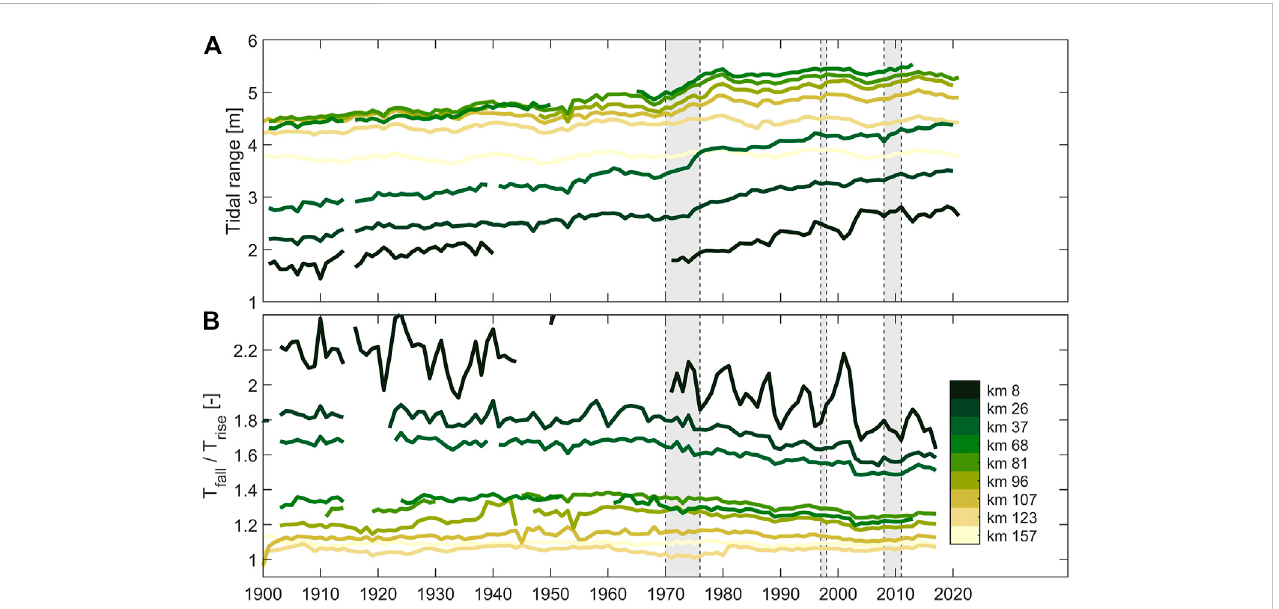
FIGURE 5 Annualtidalrange (A) andratioofthedurationfallingtidetorisingtide (B) intheScheldtestuary.Thetidalrangeupto2011isfromWinterwerpetal.(2013) andafter2011fromhttps://www.scheldemonitor.be/;ebbto fl oodratiosarefromVandenbruwaeneetal.(2019a).ThedataisoriginallycollectedbytheDutch Ministry of Public Works and the Hydrological Information Centre (HIC) of Flanders Hydraulics Research. Periods of major deepening are indicated with grey shading. During the 1971 – 1976 deepening the river bed of the lower Sea Scheldt was lowered 1.5 – 2 m (van Braeckel et al., 2006). During the 1997 – 1998deepeningtheaccesschannelsthroughtheWesternScheldtwasdeepenedwith ~1 m;thelowerSeaScheldtwasespeciallydeepened with~2 m betweenkm81and96(IMDC,2013a).Theaccesschannelwasdeepenedwithanother1.7 mseawardofapproximatelykm96between2008and2010(IMDC, 2013b).Stationsnames(inkm)areexpressedastheirdistance fromthetidallimit(thesluices atGent)andcorrespondtothefollowinggaugingstationnames: Melle (8 km), Schoonaarde (26 km), Dendermonde (37 km), Schelle (68 km), Antwerpen (81 km), Liefkenshoek (96 km), Bath (107 km), Hansweert (123 km), and Vlissingen (157 km; the estuary